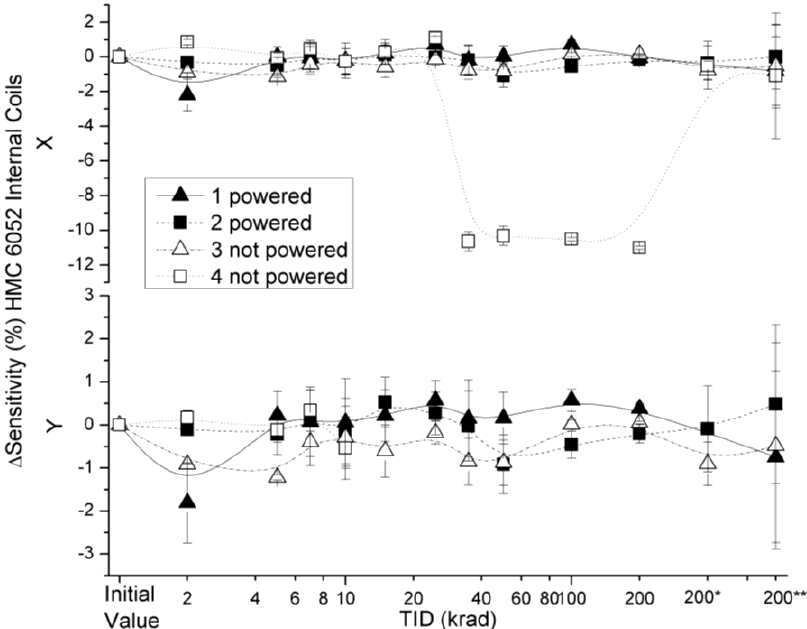
Figure 14. Sensitivity deviation measured for internal coils configuration as a function of TID for powered and non-powered HMC